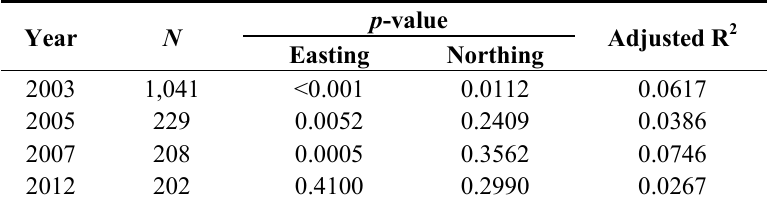
Table 3. Results of generalized additive models predicting the day of year of WNV case onset as a function of the eastings and northings of their respective ZCTAs.